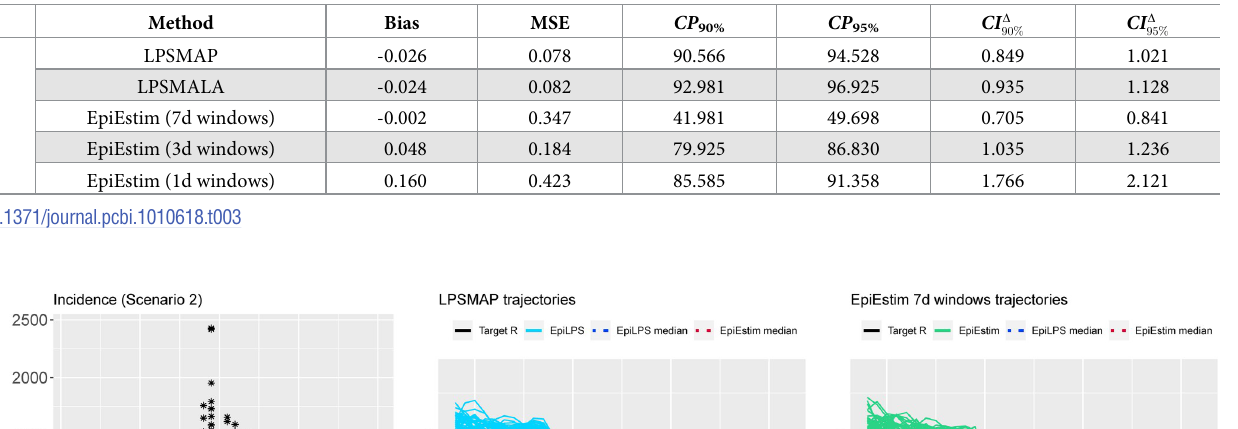
Table 3. Results for EpiLPS and EpiEstim in Scenario 9 for S = 100 simulated epidemics. The Bias, MSE, coverage probability ( CP ) and width ( CI Δ ) of 90% and 95% credible intervals for R are averaged over days t = 8, ... , 60. For EpiEstim, R t